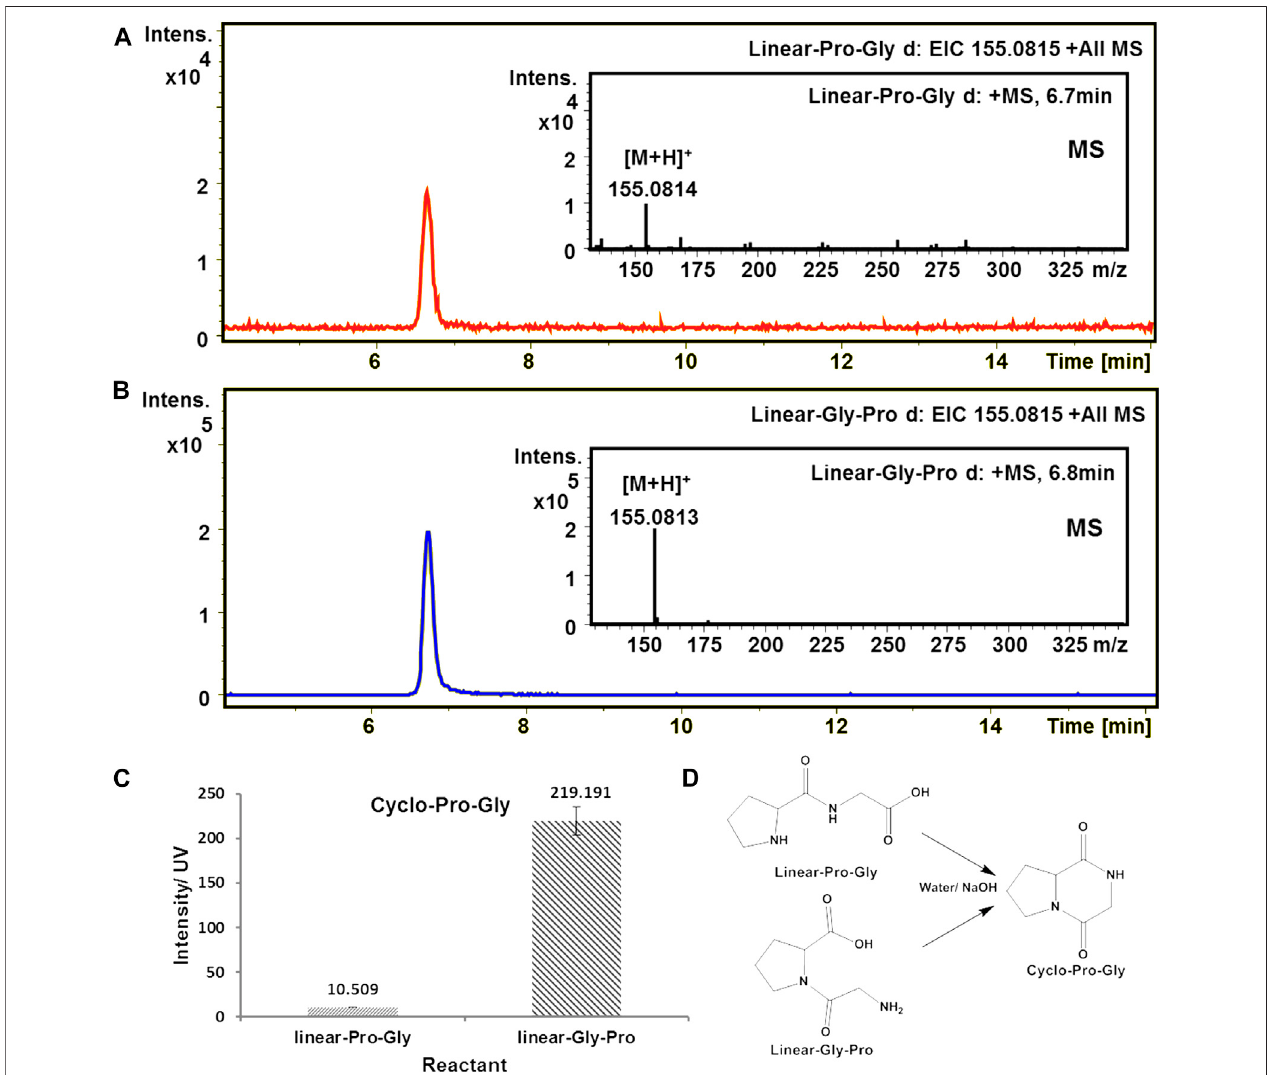
FIGURE 1 | Formation of cyclo-Pro-Gly from the cyclization of the linear dipeptide in an alkaline aqueous solution (pH (cid:2) 11). The calculated value of cyclo-Pro-Gly [M + H] + is 155.0815. (A) EIC-MS pro fi le of the product cyclo-Pro-Gly from the cyclization of linear-Pro-Gly. (B) EIC-MS pro fi le of the product cyclo-Pro-Gly from the cyclization of linear-Gly-Pro. (C) The amount of cyclo-Pro-Gly was produced from linear-Pro-Gly and linear-Gly-Pro, respectively. (D) The reaction of the cyclo-Pro-Gly formation through the cyclization of linear-Pro-Gly and linear-Gly-Pro, respectively.